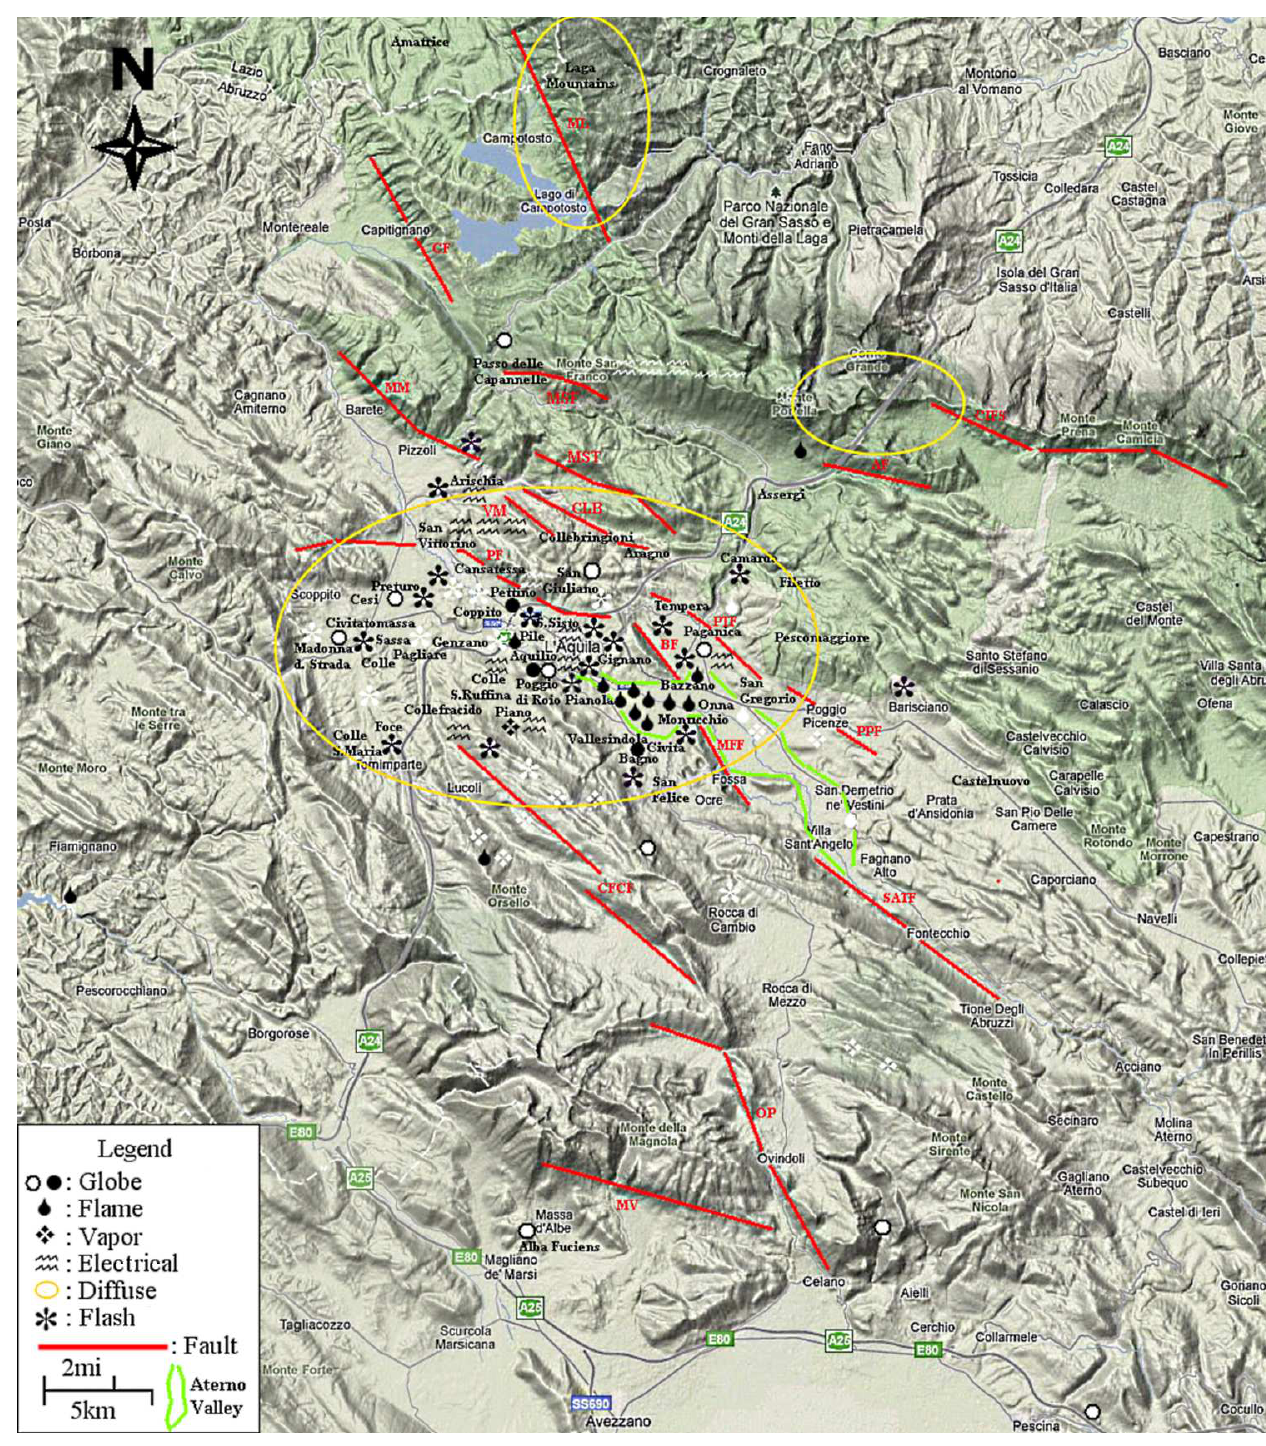
Fig. 4. Geographical distributions of EQLs on the map retrieved from Google Maps website http://maps.google.pt/; the symbols were specified in the legend; black colour indicate during and after the main shock, white colour indicate before. Primary active faults in the region of the sightings were indicated with red lines: ML, Monts of Laga Fault; CF, Capitignano Fault; MM, Mount Marino Fault; MSF, Mount San Franco Fault; MST, Mount Stabbiata Fault; CLB, Collebringioni Fault; VM, Valle del Machione Fault; AF, Assergi Fault; CIFS, Campo Imperatore Fault System; PF, Pettino Fault; PTF, Paganica-Tempera Fault; BF, Bazzano Fault; PPF, Poggio Picenze Fault; MFF, Monticchi-Fossa Fault; CFCF, Campo Felice-Colle Cerasitto Fault; SATF, Sant’Angelo-Tione Fault; Ovindoli-Pezza Fault; MV, Mont Velino Fault. Fault location from EMERGO (2010).